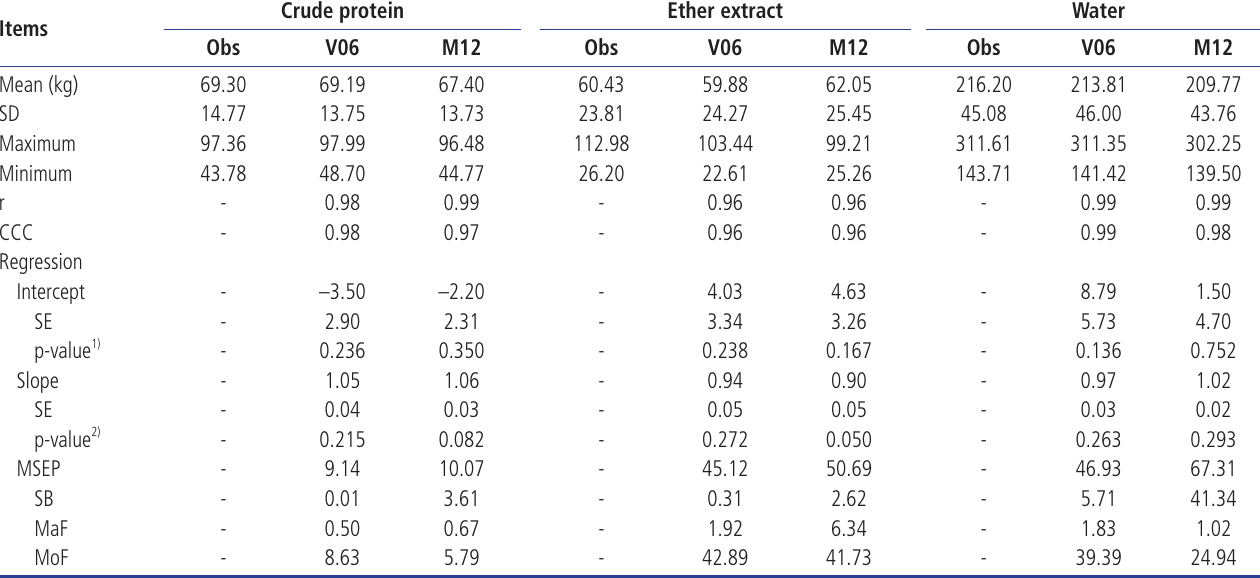
Table 6. Descriptive statistics of the relationships between the observed and predicted empty body composition values